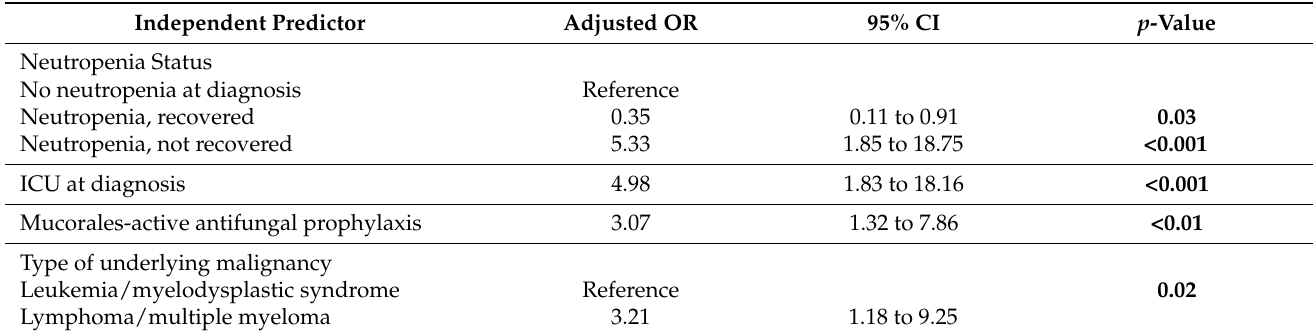
Table 2. Multivariable logistic regression model of predictors of 42-day mortality since MCR symptom